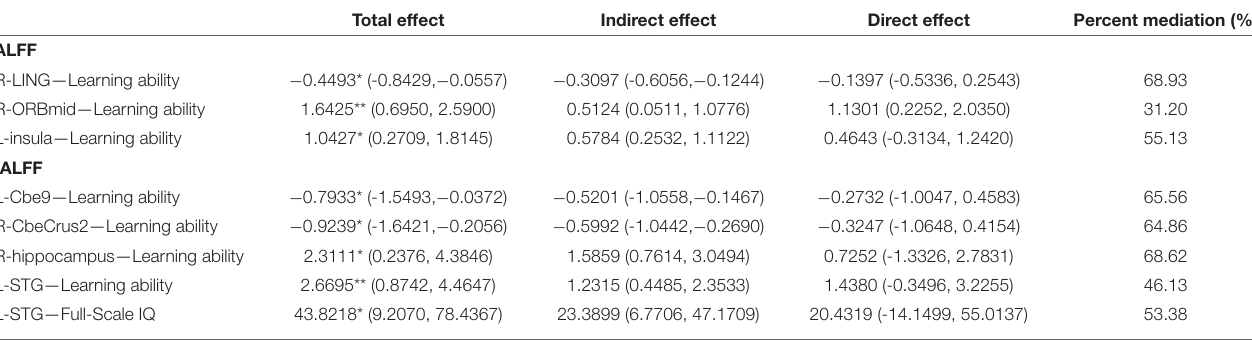
TABLE 6 | Mediation effects of environmental factors on the correlation between spontaneous brain activity and behavioral and cognitive